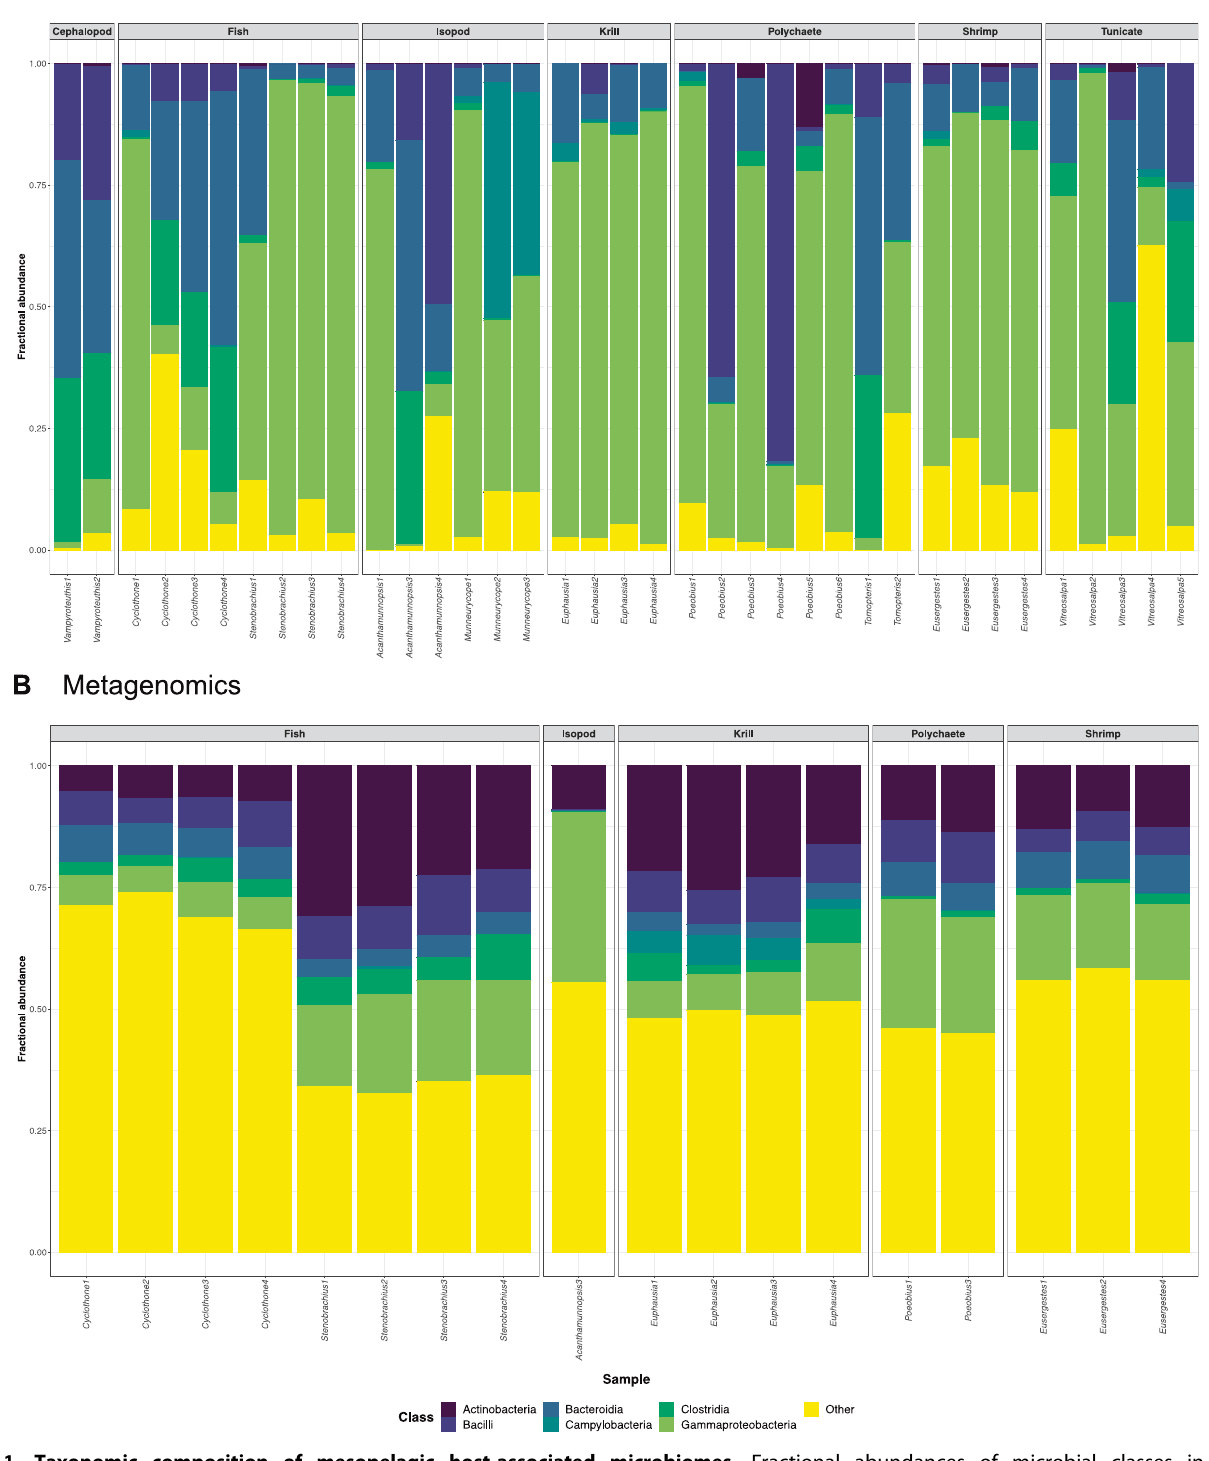
Fig. 1 Taxonomic composition of mesopelagic host-associated microbiomes. Fractional abundances of microbial classes in the microbiomes of mesopelagic animals based on A 16S rRNA amplicon data and B metagenomic data. Gammaproteobacteria, Bacteroidia, Bacilli and Clostridia were the most prevalent bacterial classes across microbiomes based on 16S rRNA gene pro fi ling (see also Table 2). These classes were also recovered through shotgun metagenomic sequencing, although with lower abundance. By contrast, a markedly higher proportion of Actinobacteria was revealed in each sample through this method (paired t -test: t = – 8.2128, p < 2.548e – 07 ).